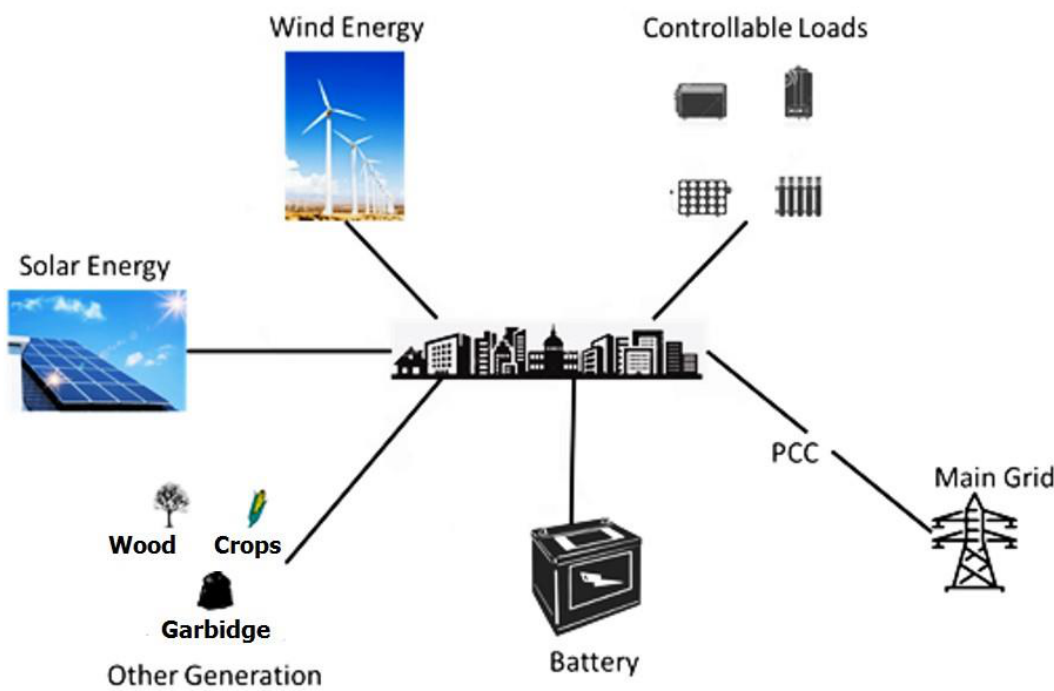
Figure 1. Microgrid system.